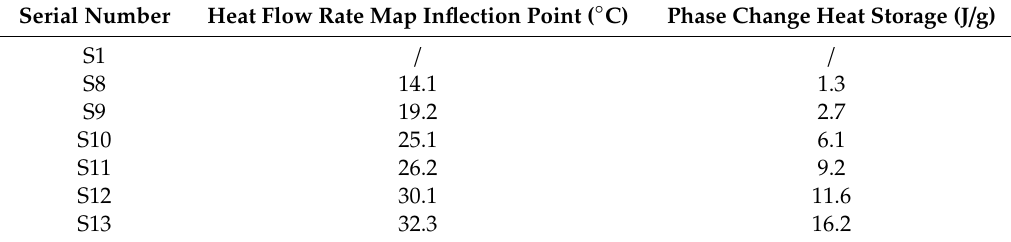
Figure 11. S1 and S8–S13 DSC diagrams. Table 4. S1 and S8–S13 heat flow diagram inflection point table.